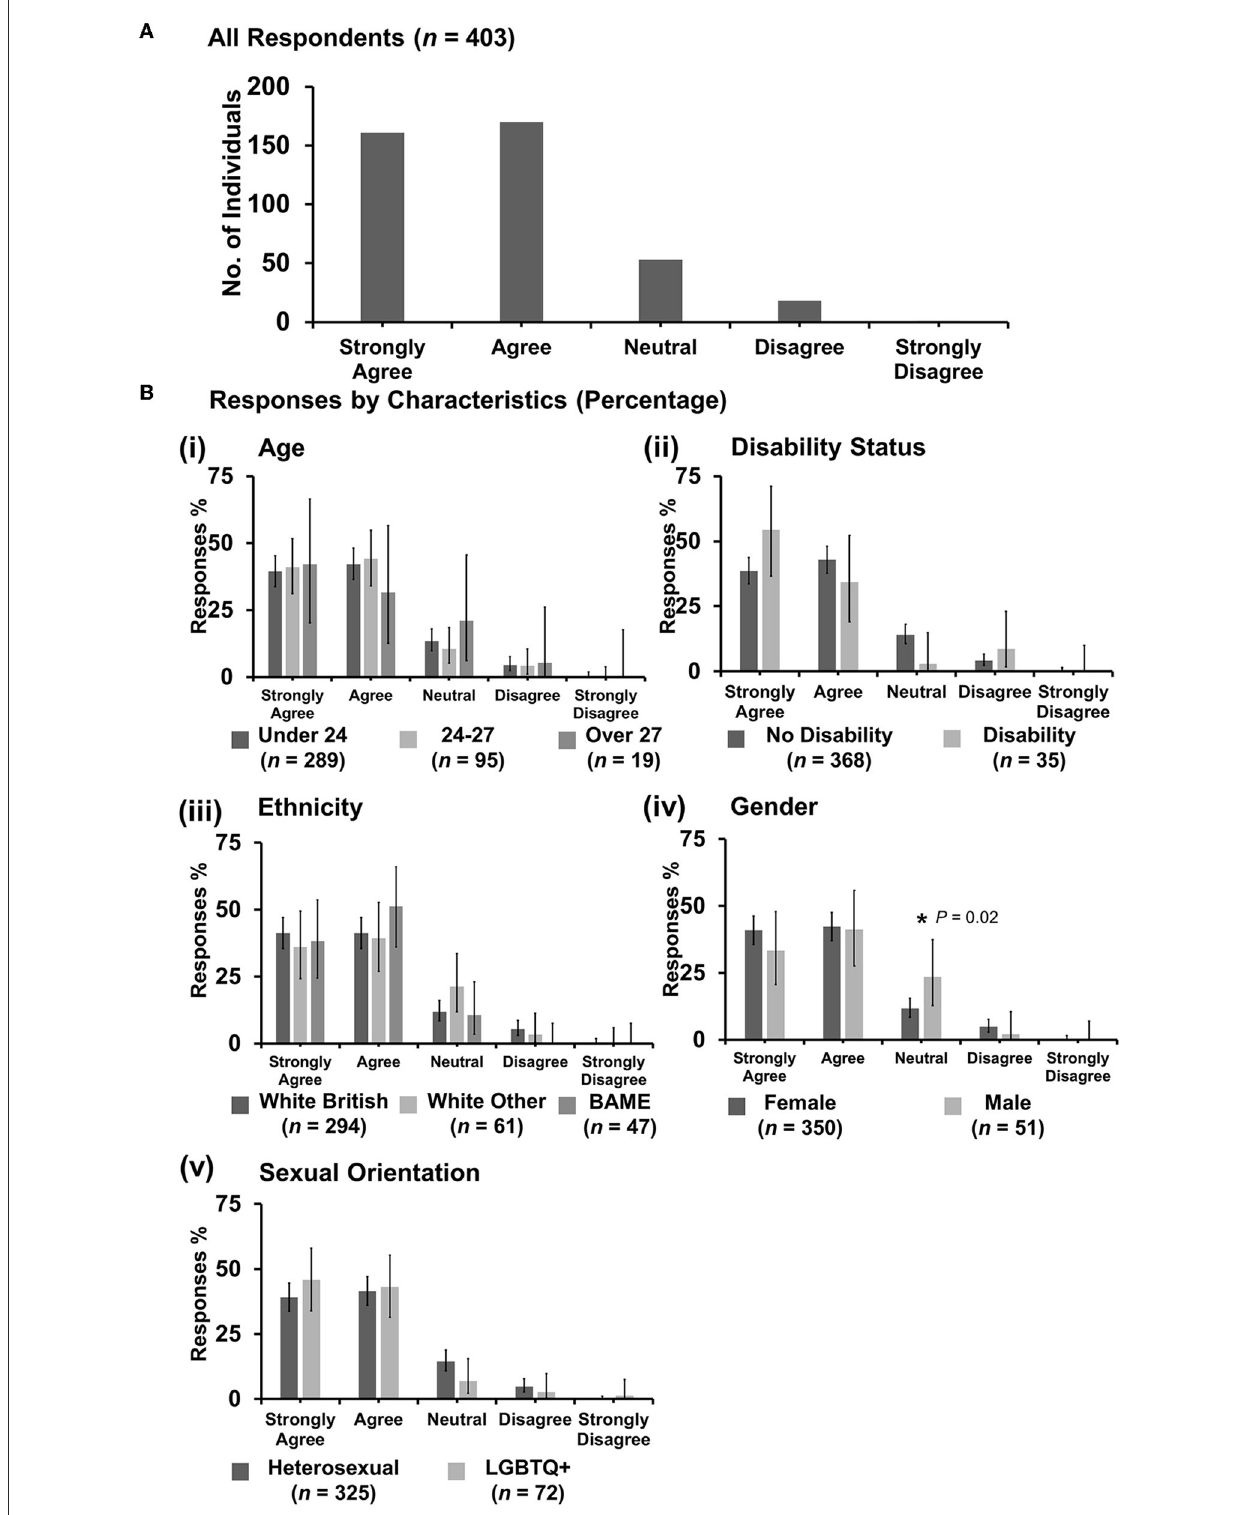
FIGURE7 Likert scale selections for the statement: discrimination against veterinary students is an important issue. (A) Bar graph demonstrating the number of respondents selecting each Likert scale response. [ (B) i–v] Bar graphs demonstrating by percentage proportion the number of responses in each Likert category by the group under the demographic categories of age, disability status, ethnicity, gender, and sexual orientation. Error bars represent 95% confidence intervals calculated by the Binomial “Exact” method. Statistical significance was determined by Pearson’s chi-squared test of association between respondent’s group under category and Likert scale selection. * P <